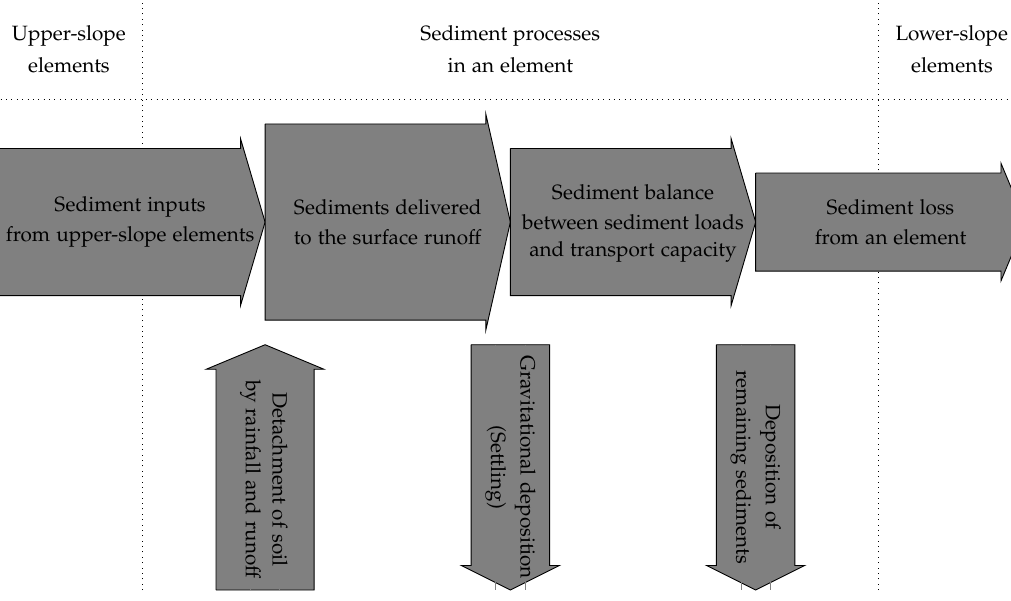
Figure 3. Schematic sediment phase of the DMMF model (modified from Figure 4 of Choi et al.